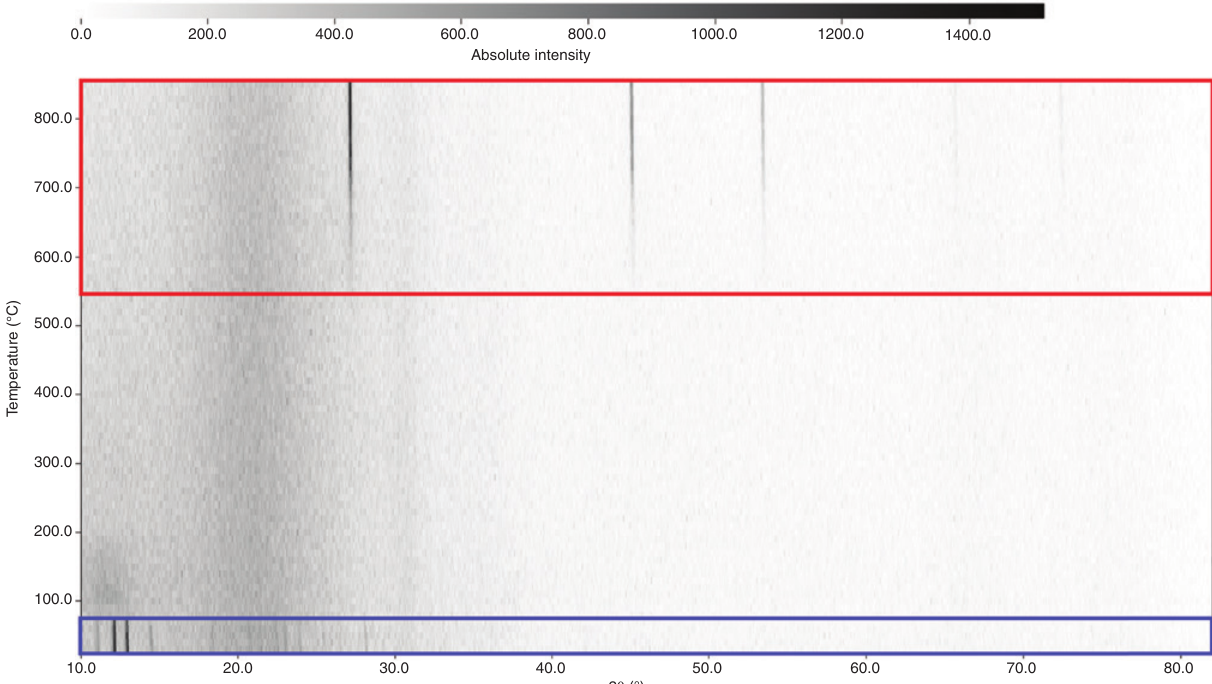
Figure 5: Temperature-dependent PXRD of 1 in sealed quartz glass capillaries confirming the formation of Ge (ICDD No. 00-004-0545).